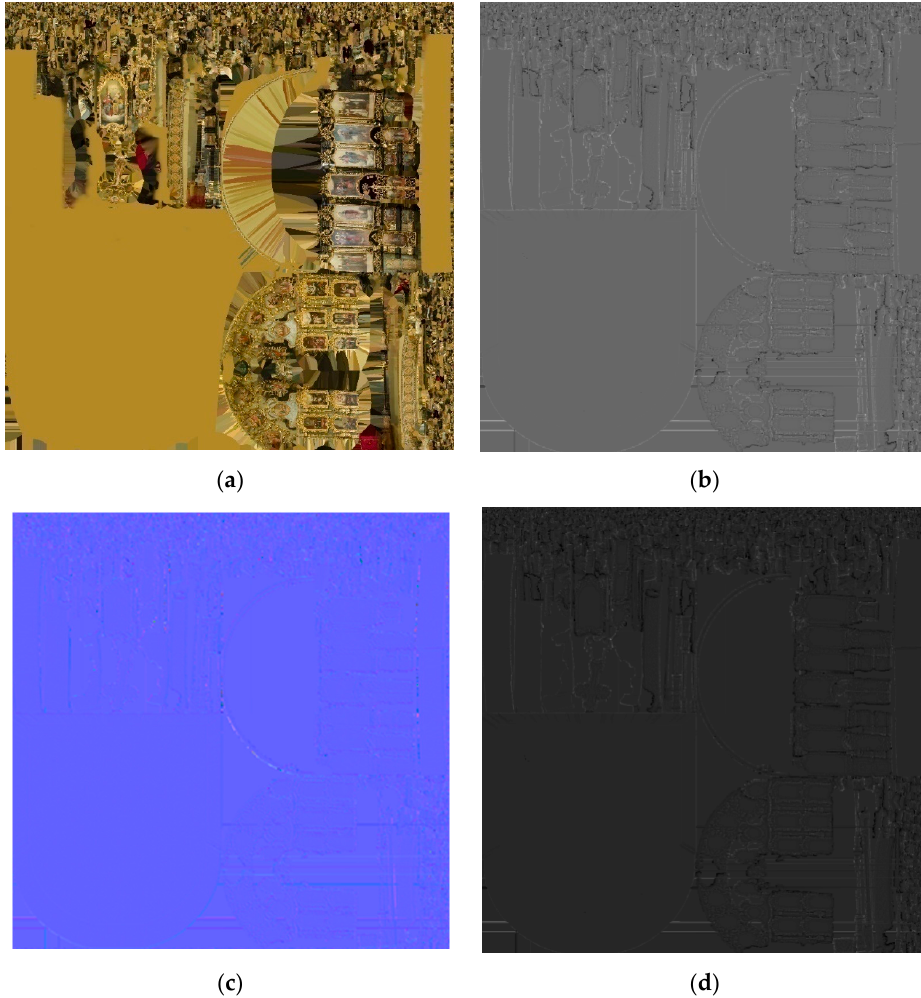
Figure 9. Maps used for model texturing: ( a ) Diffuse; ( b ) Displacement; ( c ) Normal; ( d ) Specular.